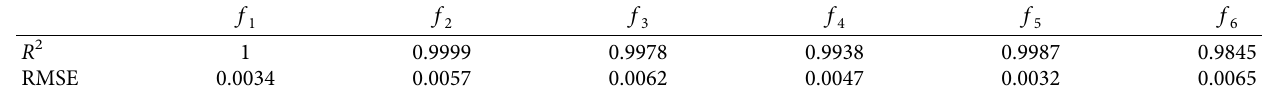
Table 3: Verifcation of the response surface model.